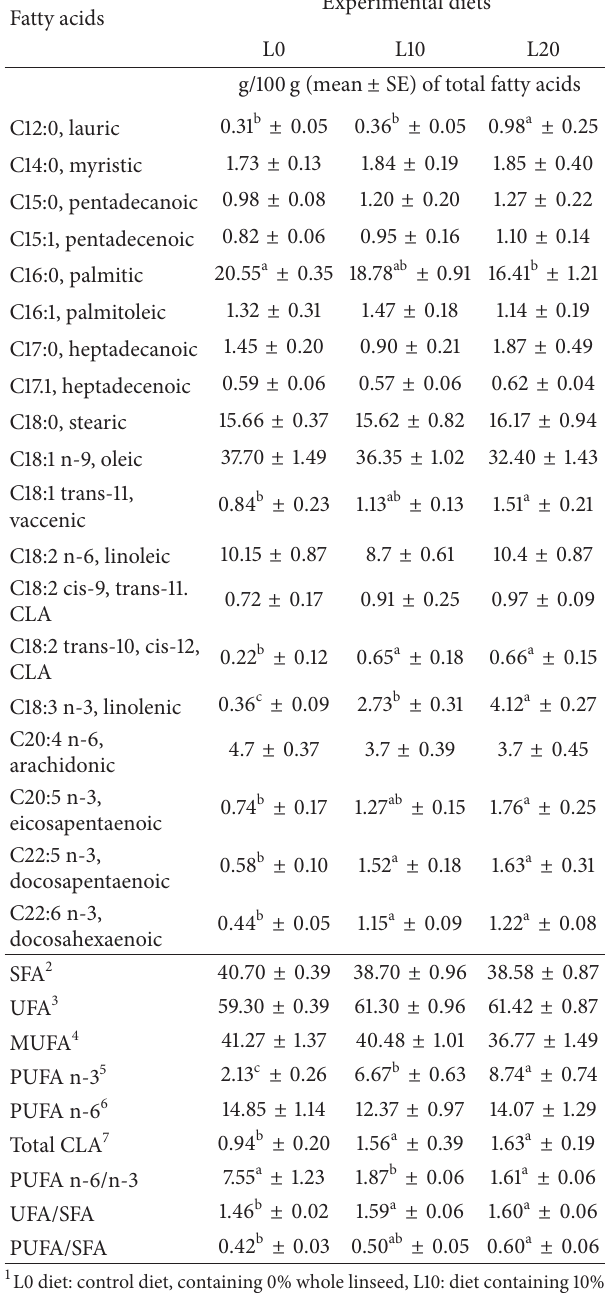
Table 4: Fatty acid profiles of the supraspinatus muscleof goats fed diets containing different levels of whole